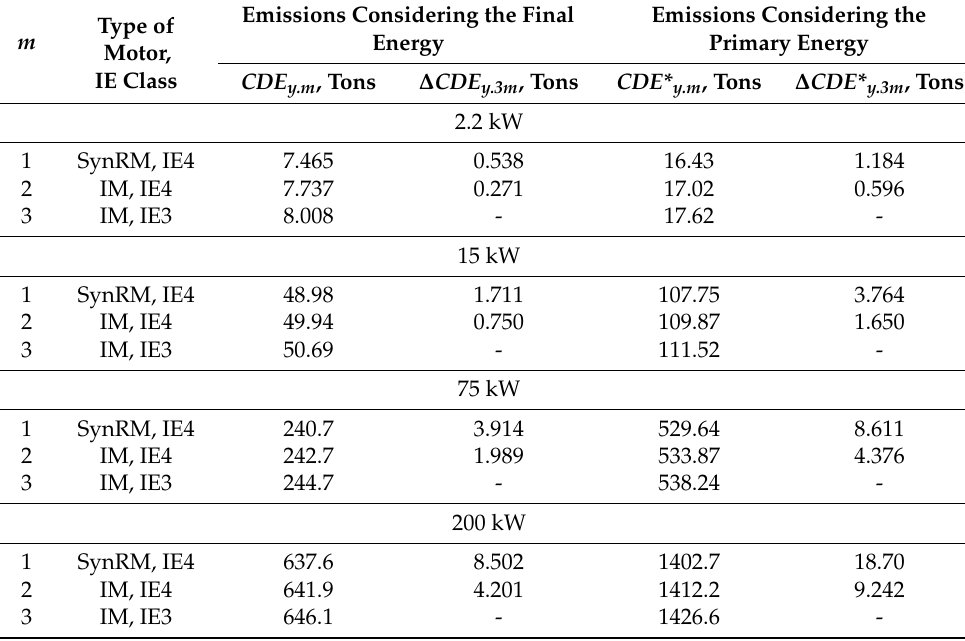
Table 7. Results of calculating the annual CO 2 emissions.